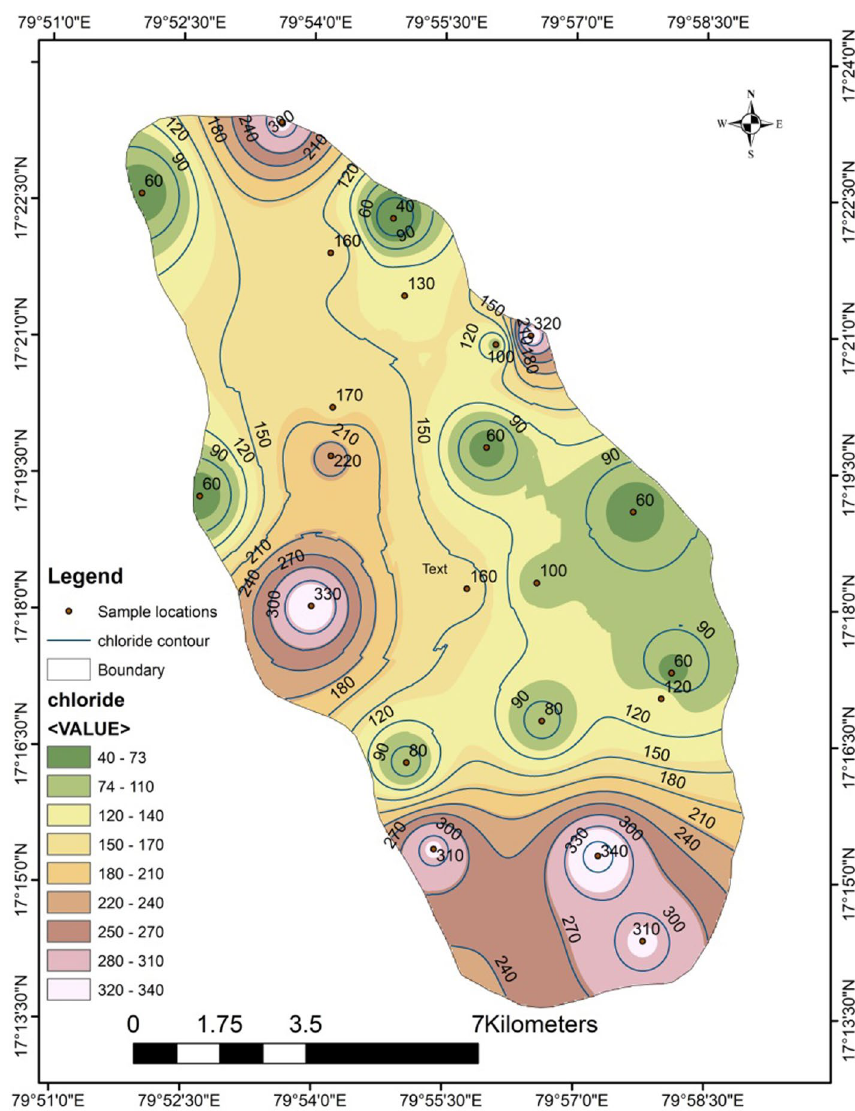
Fig. 7 Chloride distribution in the Subledu